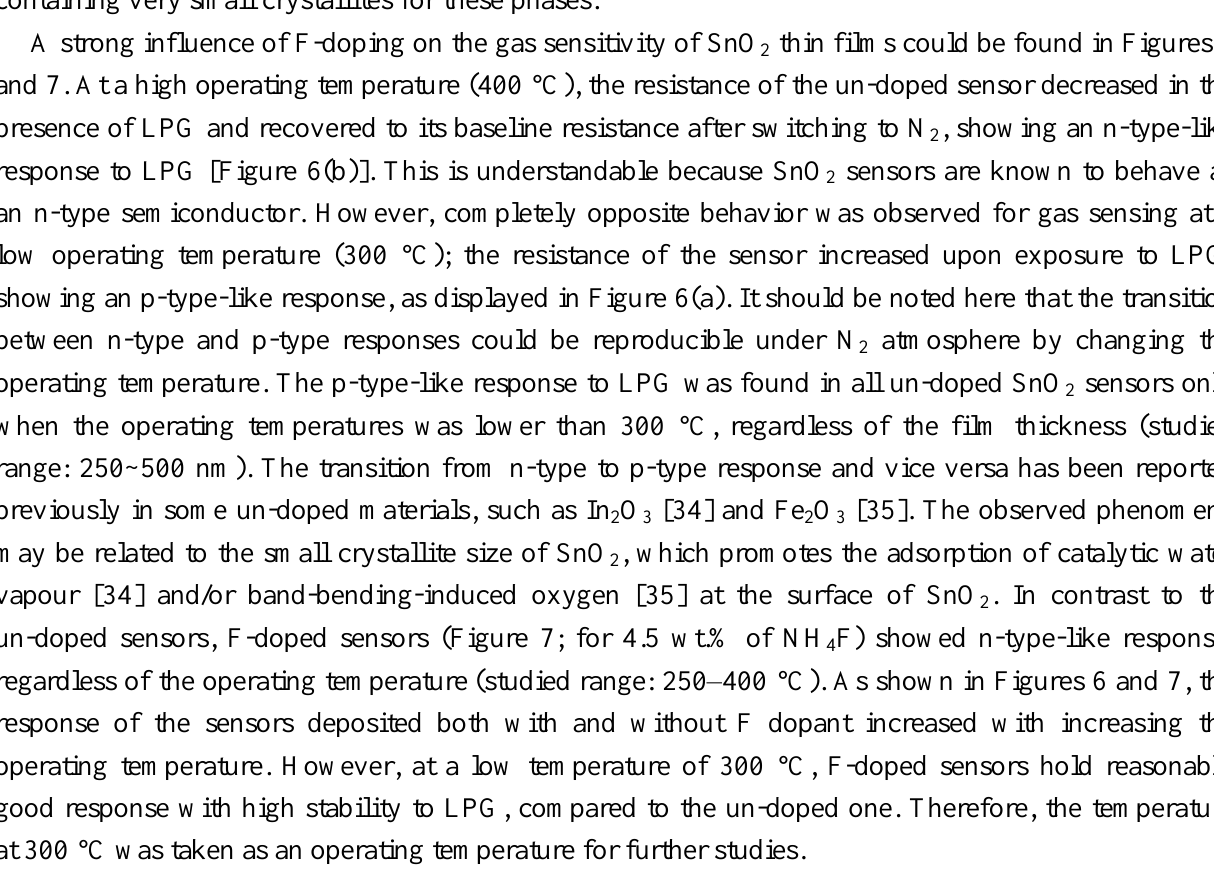
Figure 7. Change in resistances with respect to time of the 4.5 wt.% F-doped SnO in an alternating environment of N